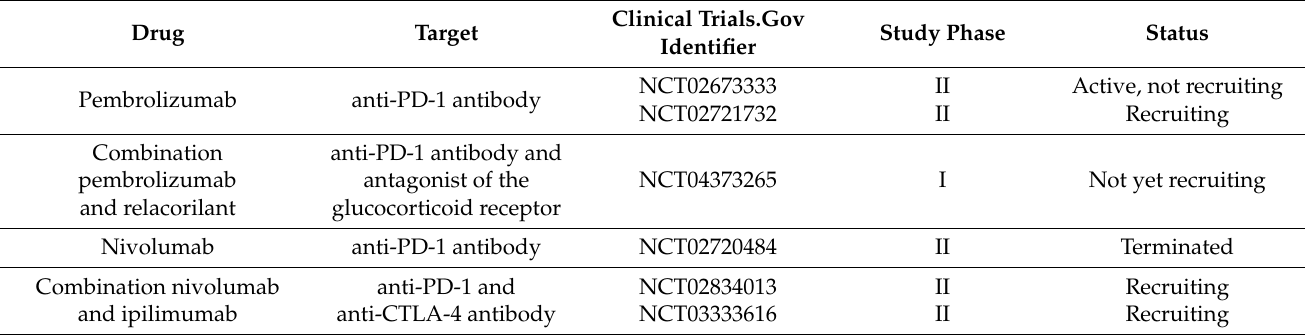
Table 1. Clinical studies investigating immunotherapy in adrenocortical carcinoma